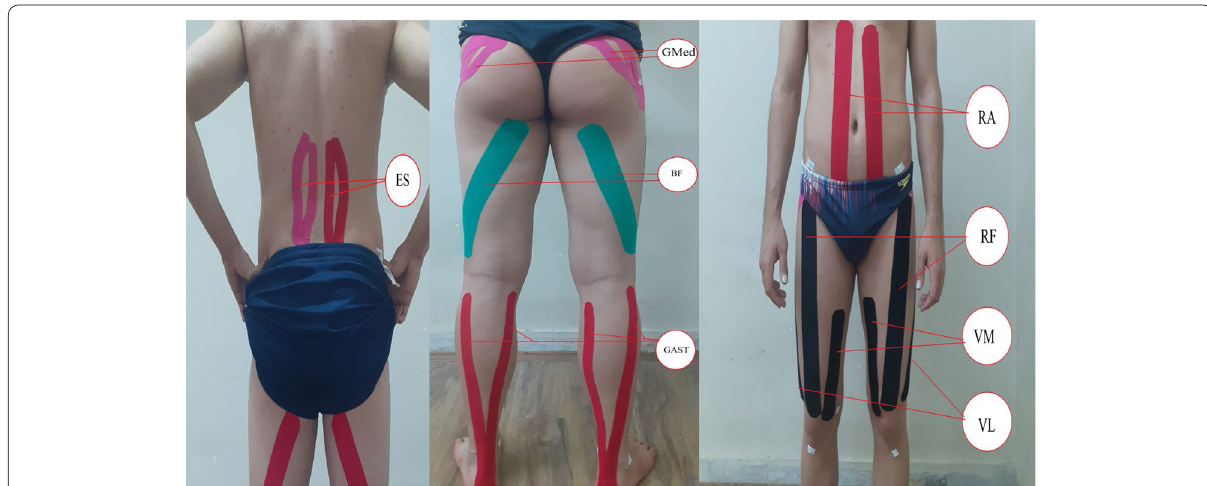
Fig. 1 Kinesio taping applications: gastrocnemius (GAST), biceps femoris (BF), vastus lateralis (VL), vastus medialis (VM), rectus femoris (RF), gluteus medius (GMed), rectus abdominis (RA), and erector spinae (ES)